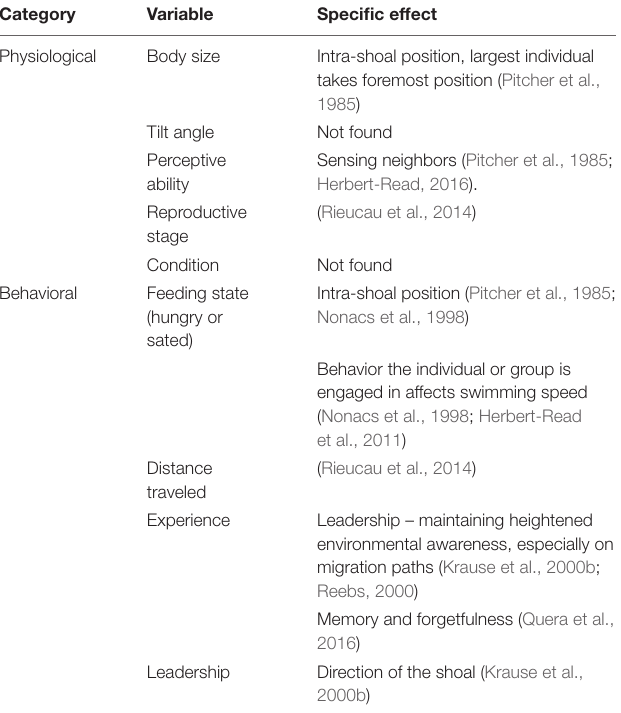
TABLE 1 | Extrinsic sources of variability in individual behavior that may affect the overall shape and density of a shoal and therefore acoustic measurements, where they are mentioned in the literature, and the specific effects of these variables, if stated.